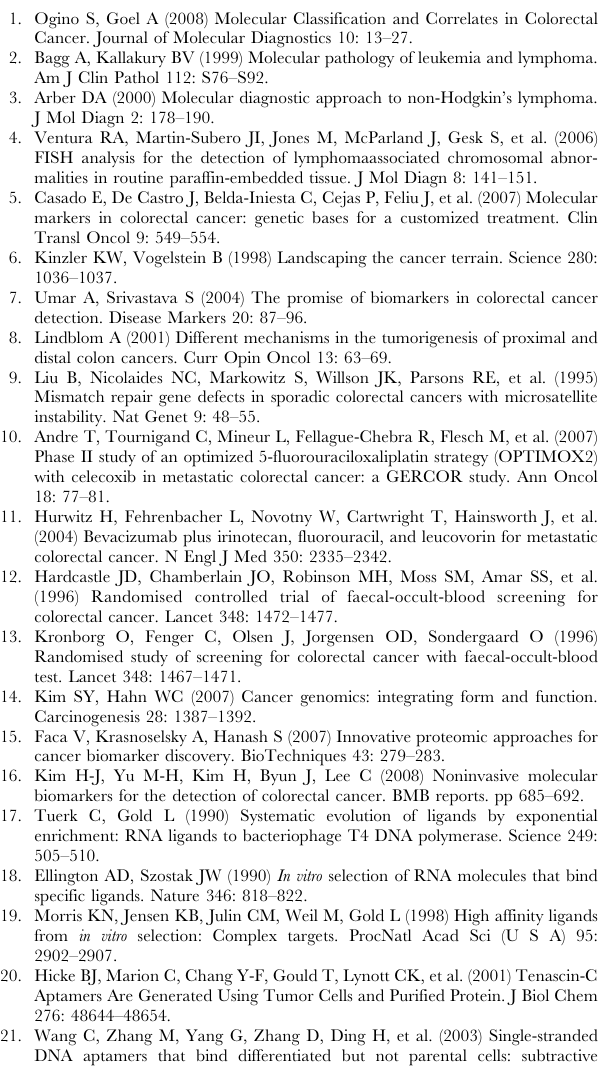
histogram (unselected library background), red (13th selected pool) and blue (14th selected pool). Figure S2 Flow cytometry dotplots showing the interaction of the RCA products with DLD-1 cells. A threshold based on fluorescence intensity of FITC in the flow cytometry was set so that about 5% of cells incubated with the FITC-labeled DNA library represent fluorescence intensity background (lower right quadrant), and the binding event was assessed based on the percentage of cells binding over the threshold. Figure S3 Flow cytometry dot plot showing the interaction of aptamer with normal human colon cells. Found at: doi:10.1371/journal.pone.0014269.s003 (1.83 MB TIF) Figure S4 Assessment of the effect of binding KDED19, KC2D4, and KC2D8 to DLD-1 cells in the presence of excess of unlabeled Sgc8. Red histogram (control background); green (aptamer binding without excess of unlabeled Sgc8) and blue (aptamer binding in the presence of excess unlabeled Sgc8). Found at: doi:10.1371/journal.pone.0014269.s004 (1.35 MB TIF)